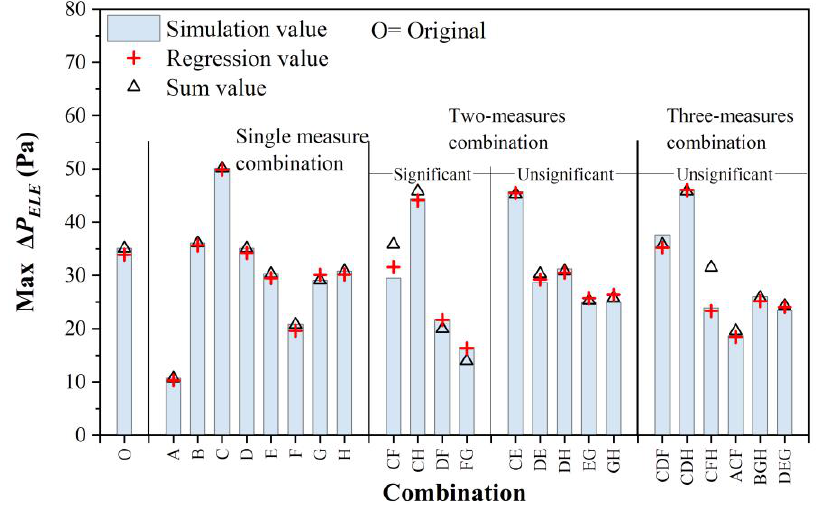
Figure 14. The maximum pressure difference at elevator doors: the contrasts of the regression and sum values.